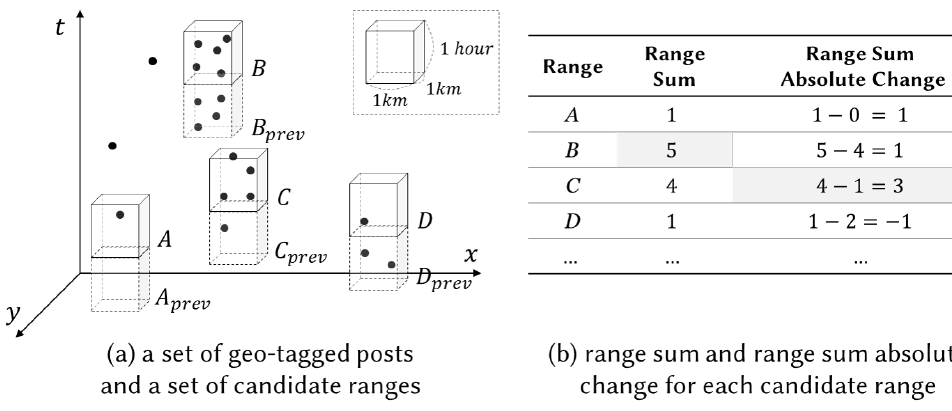
Figure 1. An example dataset and query